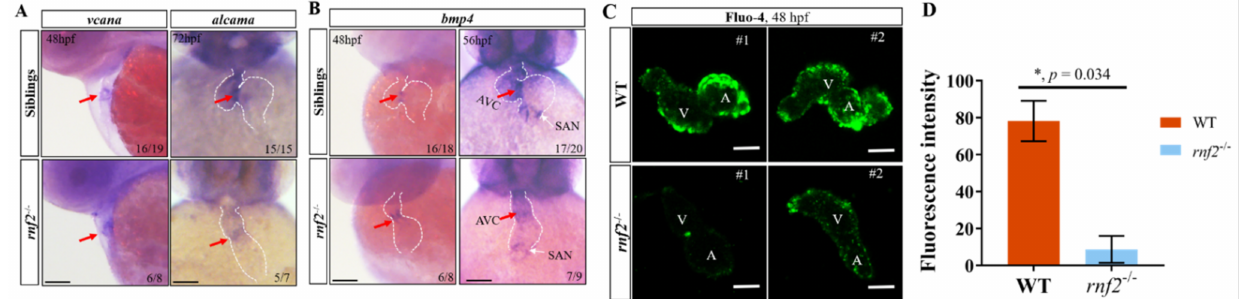
Figure 6. Rnf2 deficiency caused defects in the cardiac conduction system. ( A ) Expression of AVC myocardial markers vcana and alcama ; ( B ) Expression of AVC endocardial and SAN marker bmp4 . Red arrows indicate AVC; ( C ) Fluo-4 staining detects calcium signal intensity in the hearts of rnf2 − / − or wild-type embryos; V, ventricle; A, Atrium; #1/#2, sample number; n = 2. ( D ) Quantification of fluorescence intensity in Figure 6C. *, p < 0.05; Scale bar: 0.2